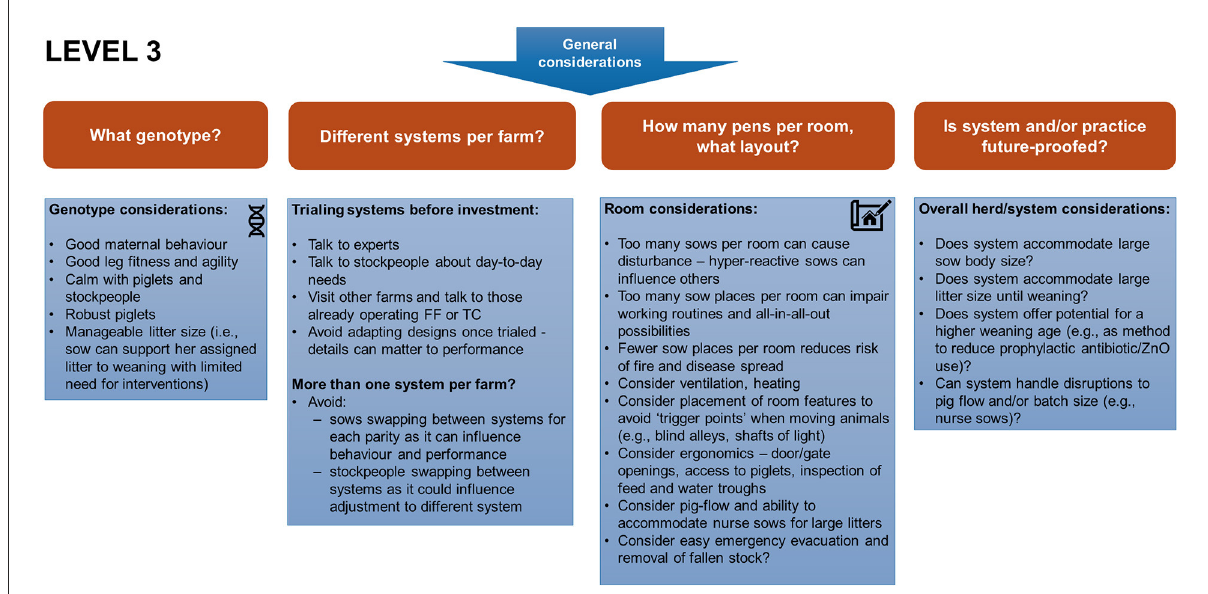
practice is fit for now or the